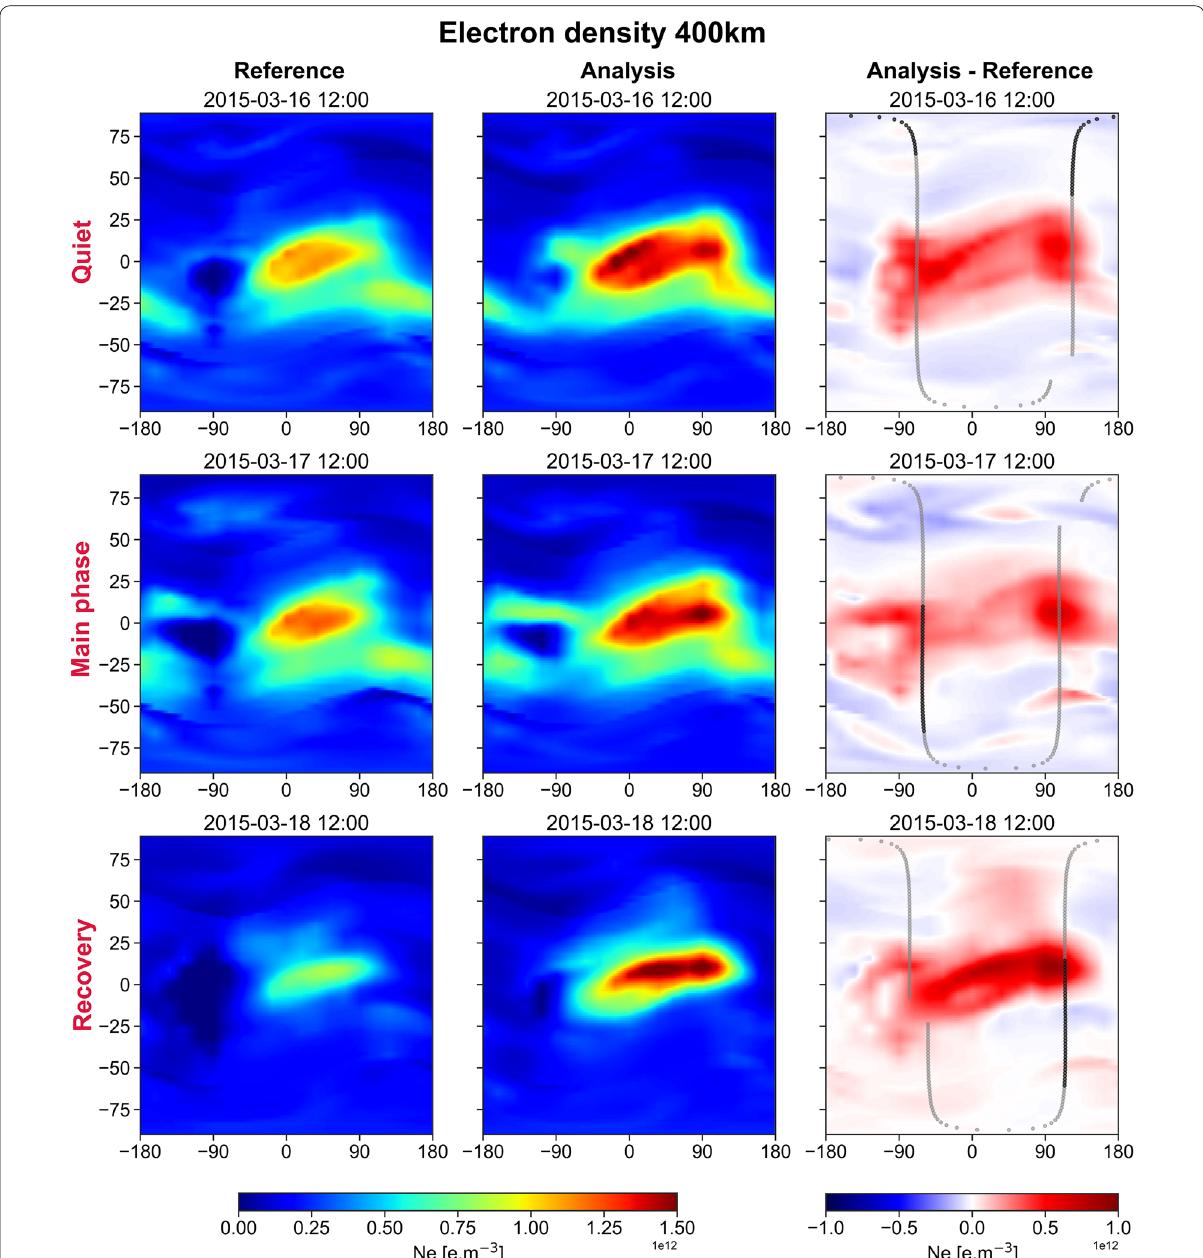
Fig. 4 Electron density maps at 400 km altitude for reference, analysis and analysis—reference difference at 1200 UTC (columns) during quiet, main phase and recovery days (rows). The location of Swarm‑A orbit track is represented in the difference plot (grey line) with a highlighted area (black) of the last two assimilation intervals before 1200